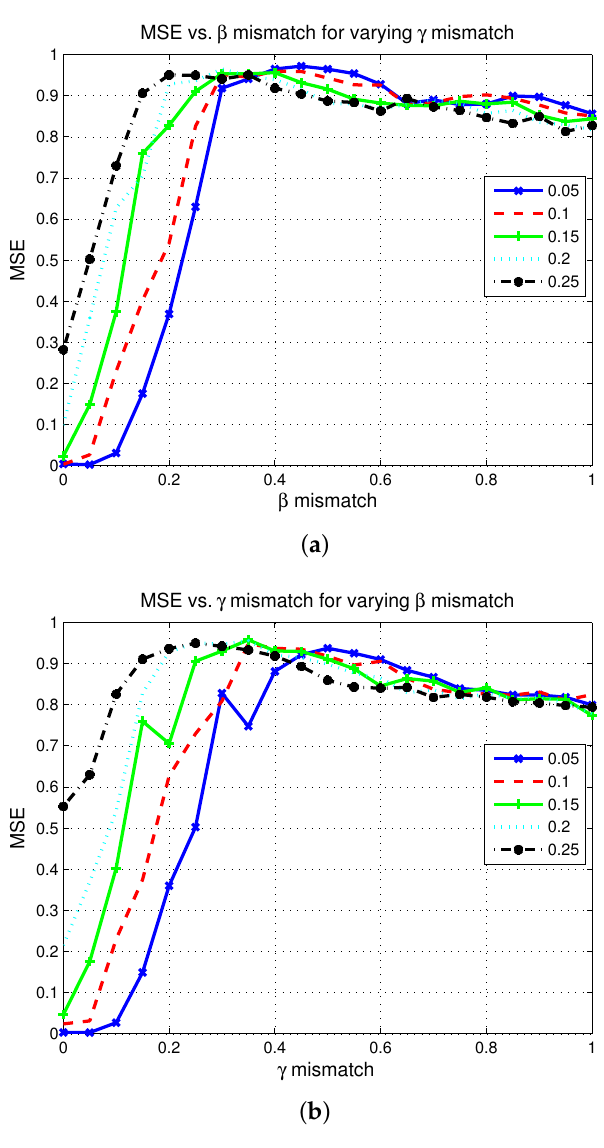
Figure 5. ( a ) Mean square error (MSE)versus β mismatch with varying γ mismatch. Increasing γ mismatch causes increase of error for the same level of β mismatch; ( b ) MSE versus γ mismatch with varying β mismatch. Increasing β mismatch causes the increase of error for the same level of γ